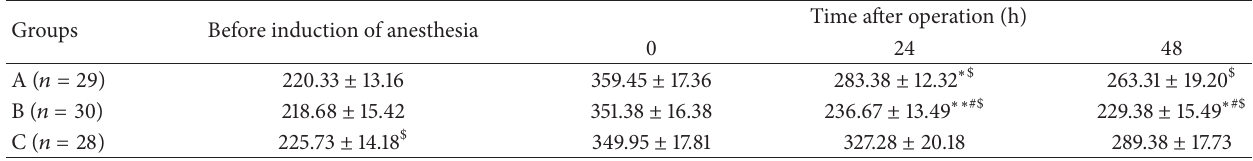
Table 5: Plasma level of IL-6 (pg/mL) among the three groups (mean ±